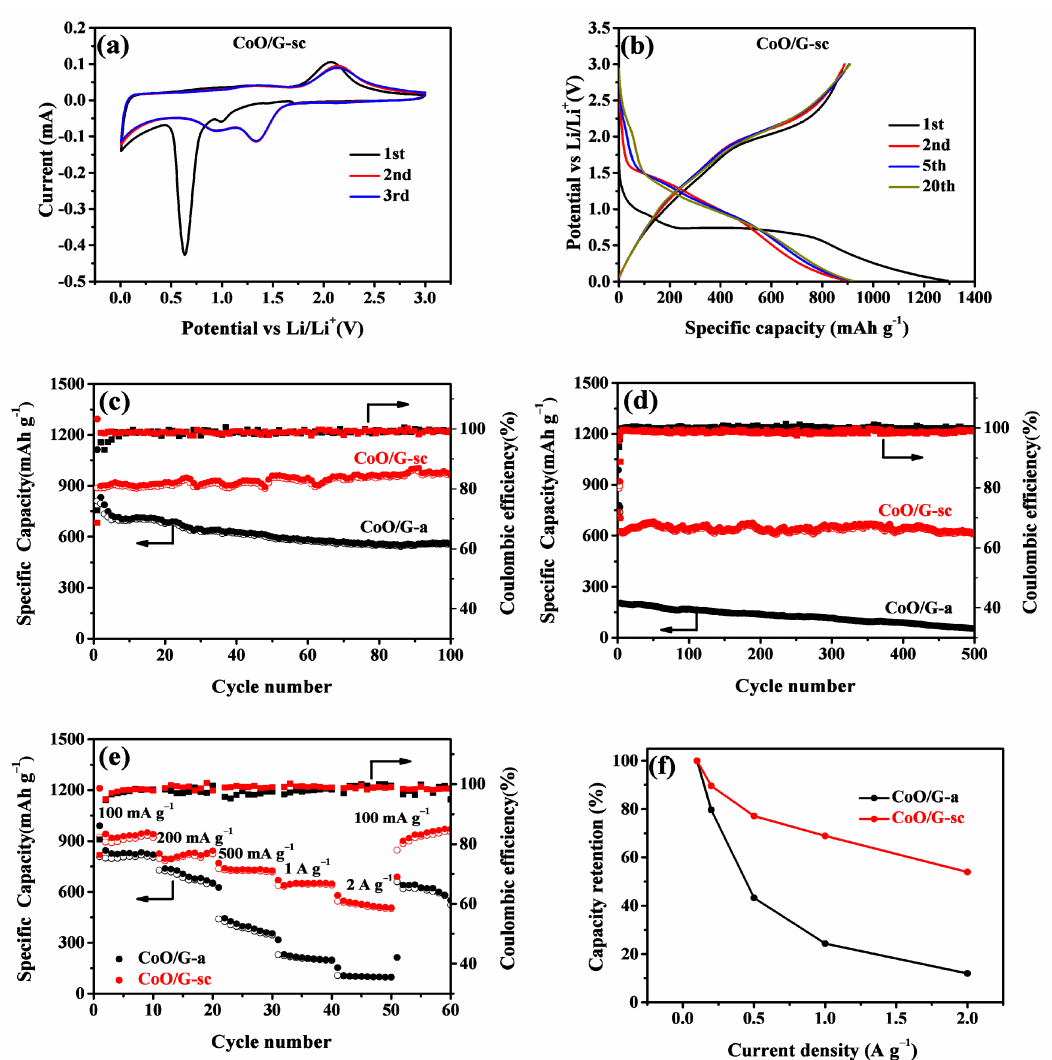
Figure 5. ( a ) cyclic voltammograms (CV) at a scan rate of 0.2 mV s − 1 and ( b ) galvanostatic charge/discharge profiles of CoO/G-sc; Cycle stability and Coulombic efficiency of CoO/G-a and CoO/G-sc at specific current of ( c ) 100 mA g − 1 and ( d ) 1 A g − 1 ; ( e ) rate performance and ( f ) capacity retention ratio relative to 100 mA g − 1 of CoO/G-a and CoO/G-sc